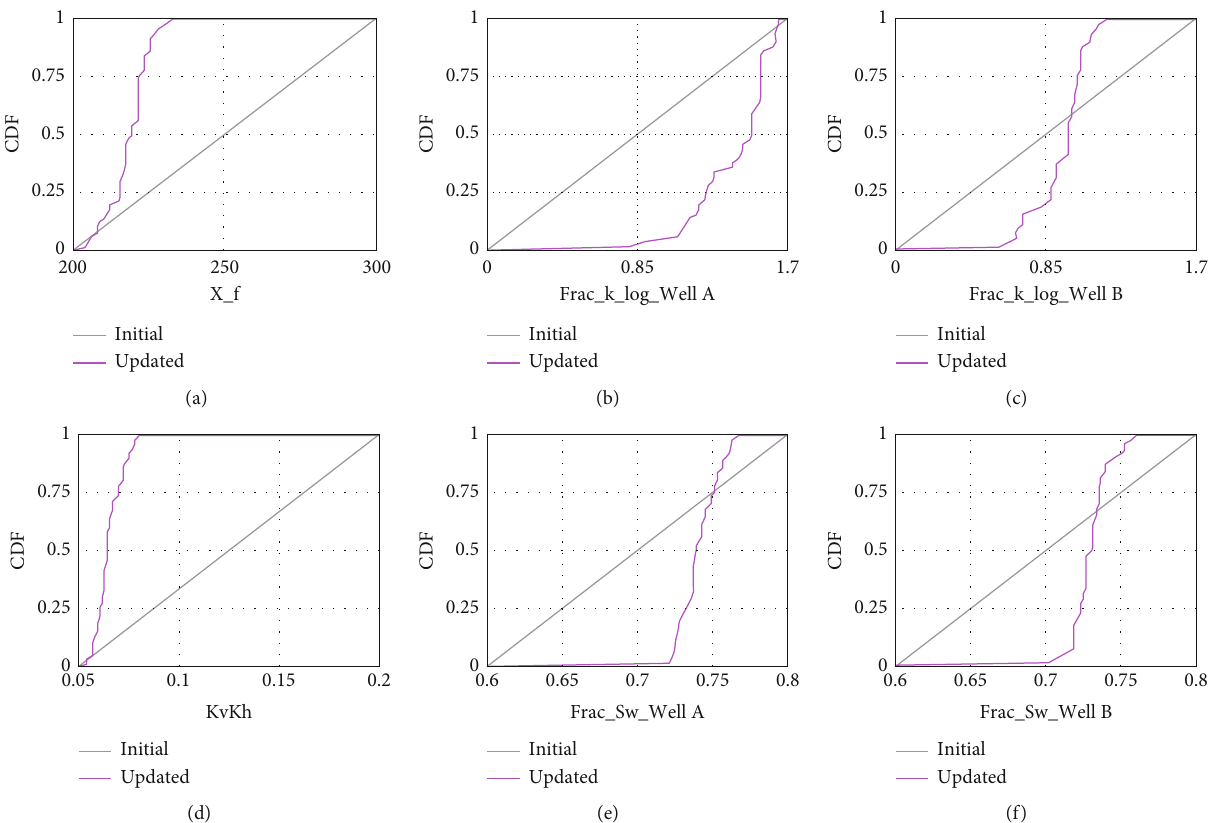
Figure 10: The cumulative distribution function of history matching parameters before/after history matching: (a) fracture half length, (b) fracture permeability for well A, (c) fracture permeability for well B, (d) permeability anisotropy, (e) fracture water saturation for well A, and (f) fracture water saturation for well